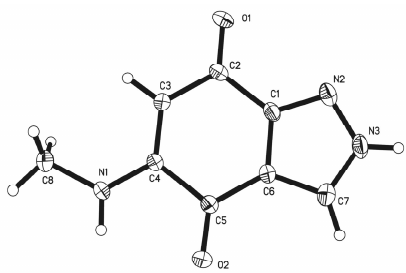
Figure 3. X-ray crystal structure of 1.